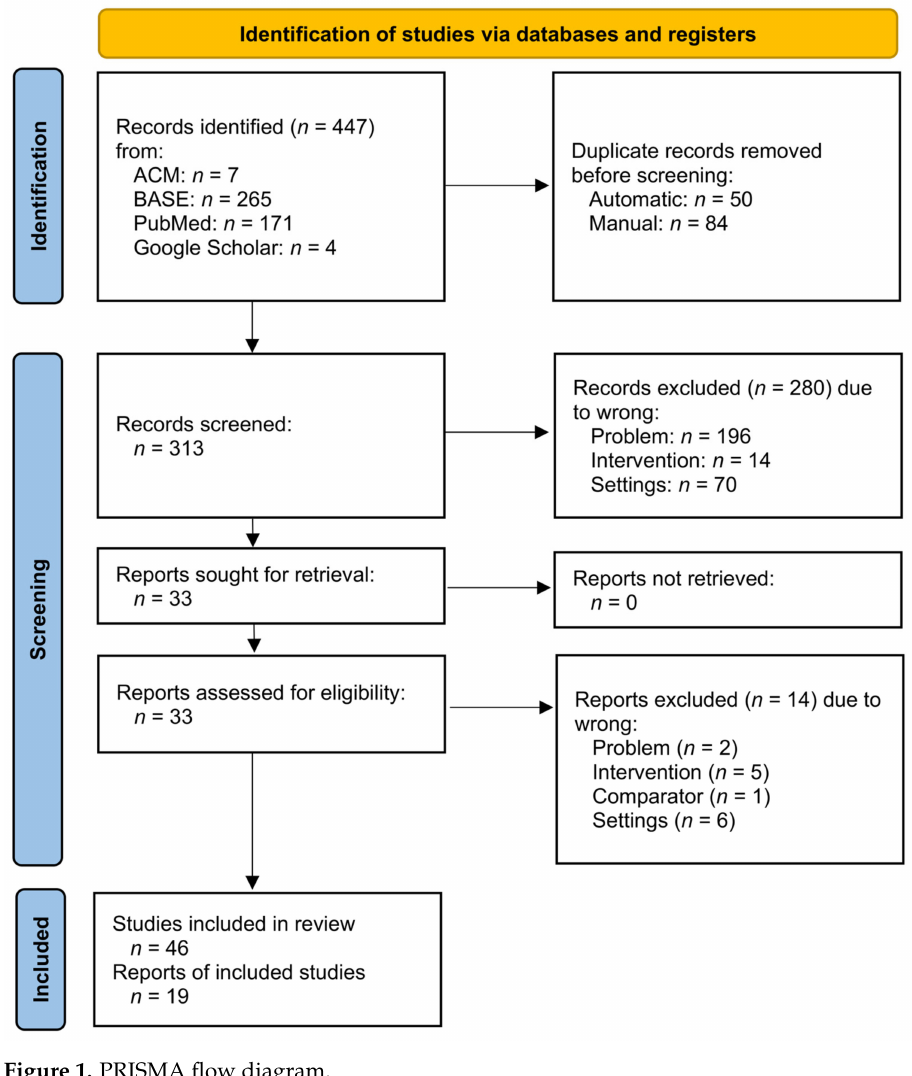
Figure 1. PRISMA flow